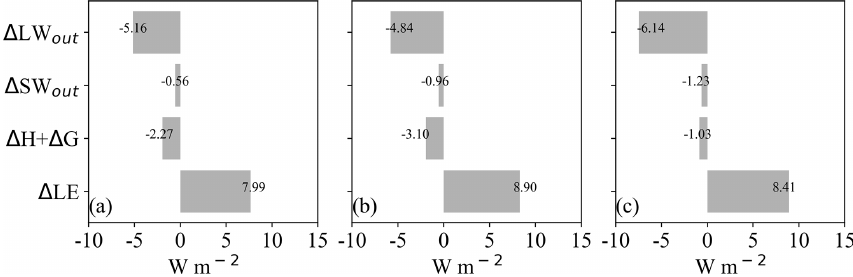
Figure 8. Afforestation-induced changes in surface energy fluxes (Wm − 2 ) following the three approaches: (a) the actual effect based on a space-and-time approach, (b) the mixed potential effect using medium-resolution land-cover maps based on a space-for-time approach, and (c) the full potential effect assuming a transition from 100% openland coverage to 100% forest coverage using the SVD method. For each approach, changes were calculated for the reflected shortwave radiation (SW out ), outgoing longwave radiation (LW out ), latent heat flux ( LE ), and the combination of sensible and ground heat fluxes ( H + G ). No changes were assumed for incoming shortwave and longwave radiation. Changes in energy fluxes for the actual effect approach have been adjusted to the condition of full afforestation (i.e., F aff = 100%) in a similar way as for the predicted (cid:49)T a in Fig. 7, by fitting linear regressions between energy flux variables and F aff (Fig.